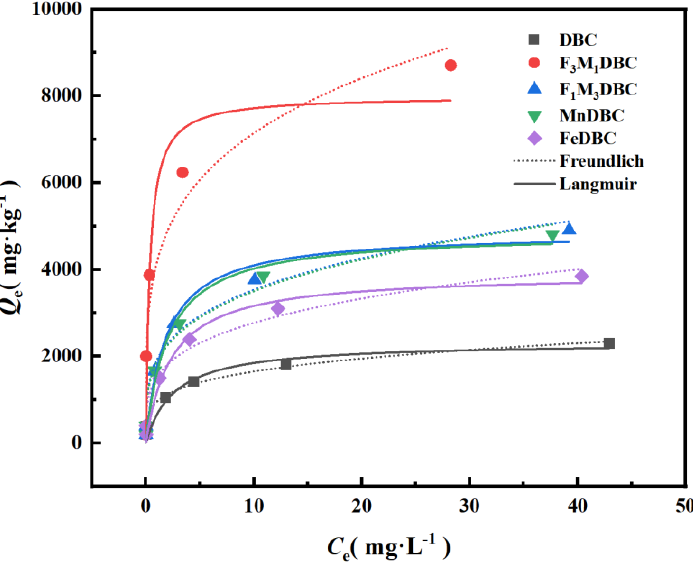
Figure 4. The sorption isotherms of atrazine by original biochar and modified biochar.